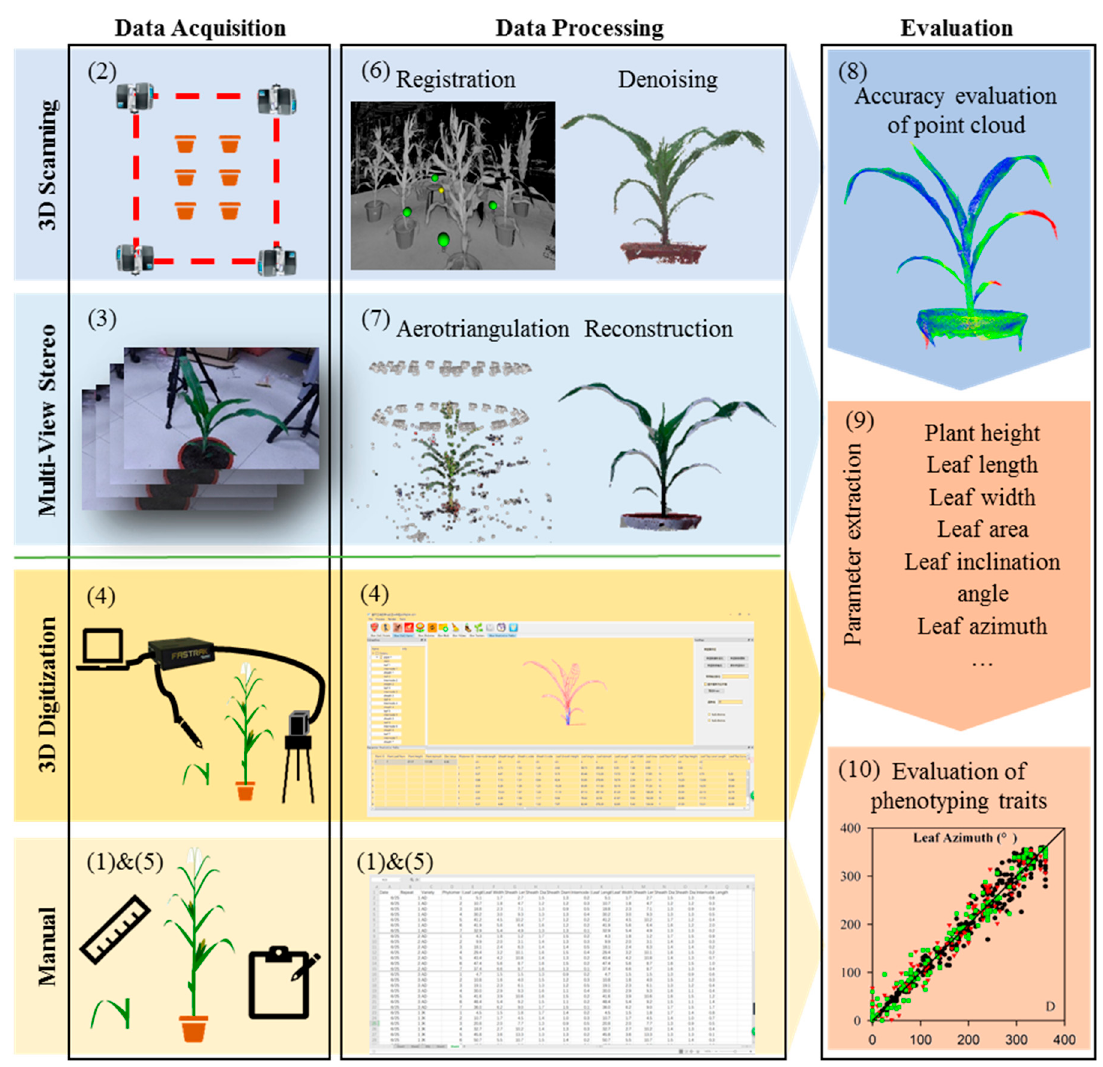
Figure 1. Workflow of data acquisition, processing, and evaluation of phenotypic parameters of maize plants.